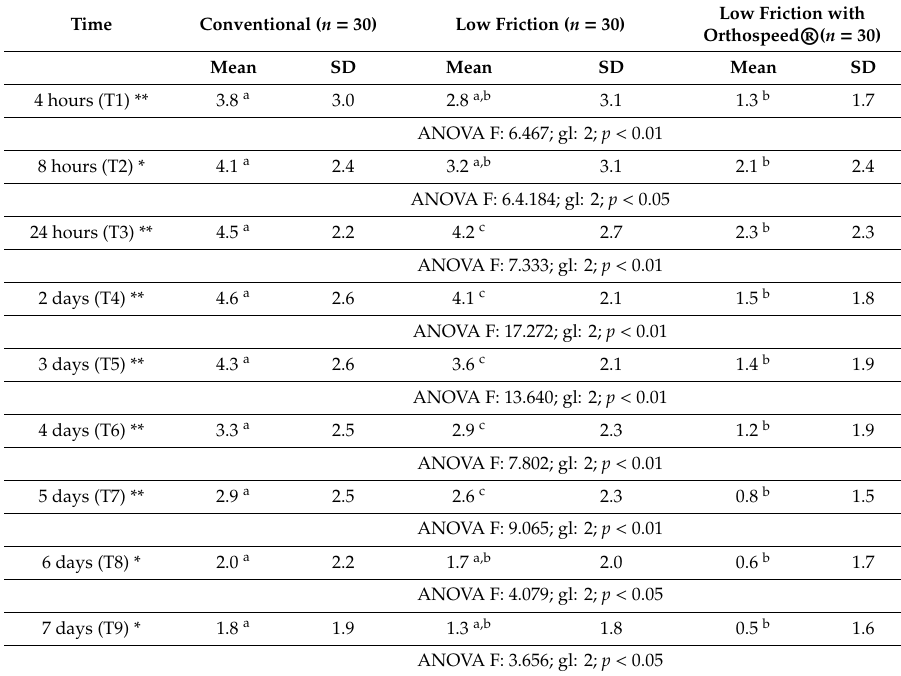
Table 2. Comparison of pain levels throughout the di ff erent assessment time points using the visual analogue scale.